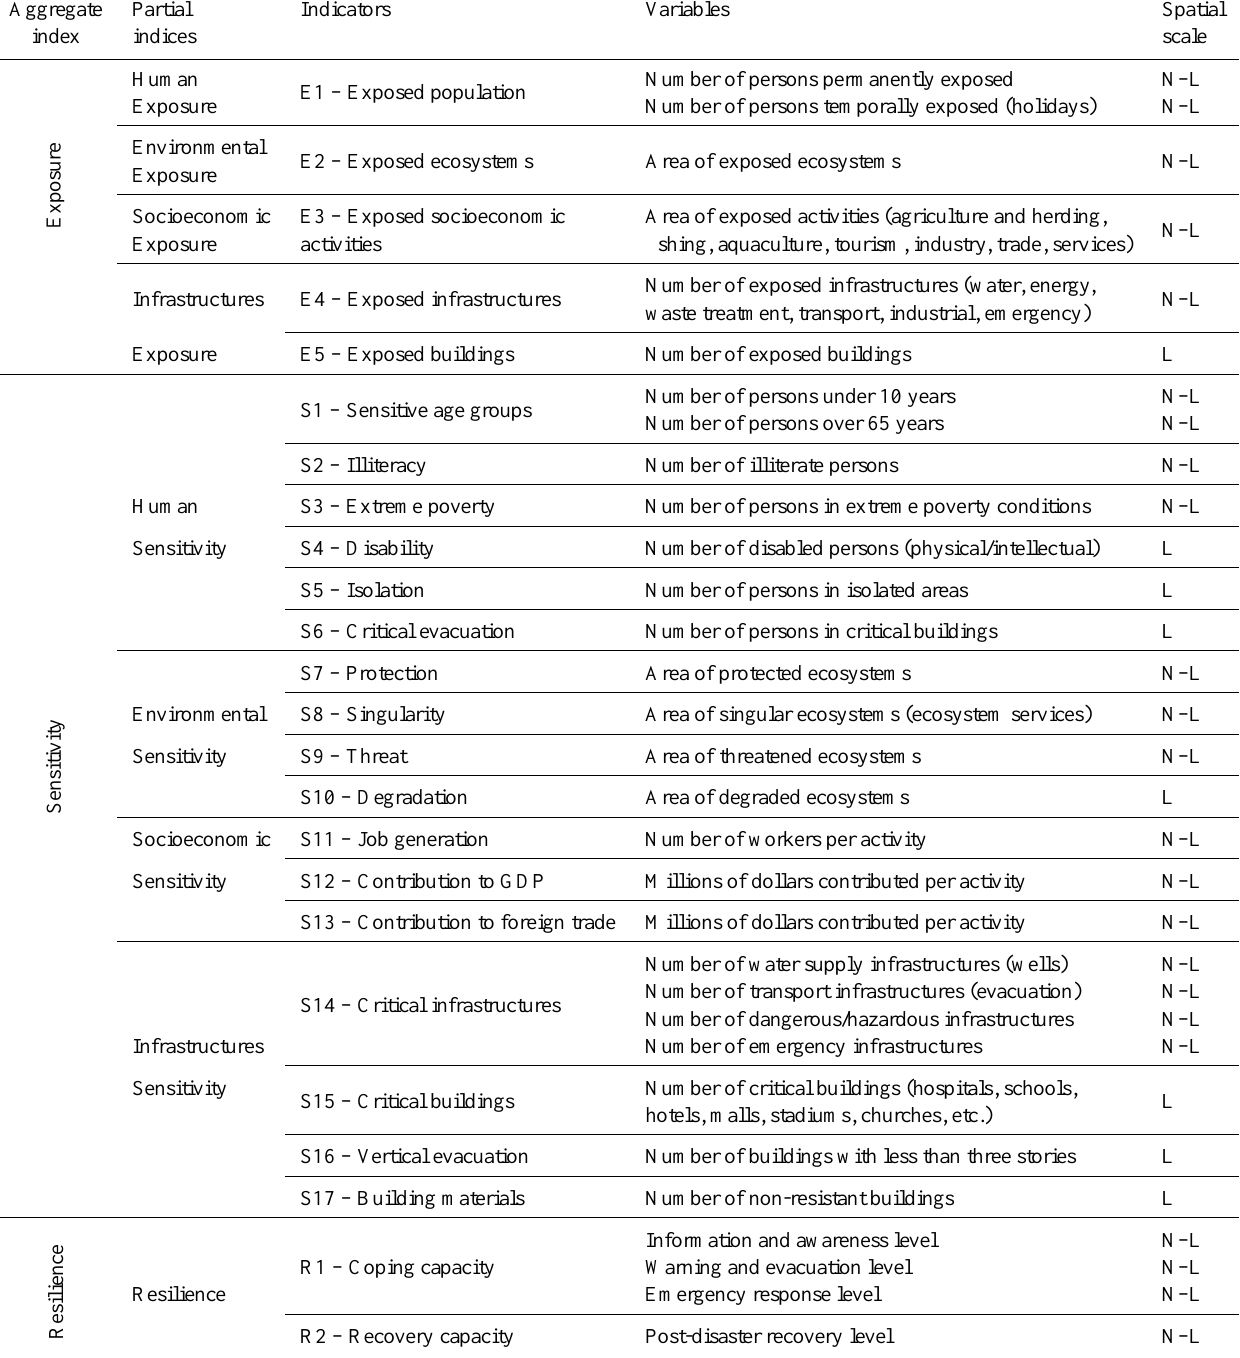
Table 2. Tsunami Exposure and Vulnerability indices and indicators (N=national scale, L=local scale, GDP=gross domestic